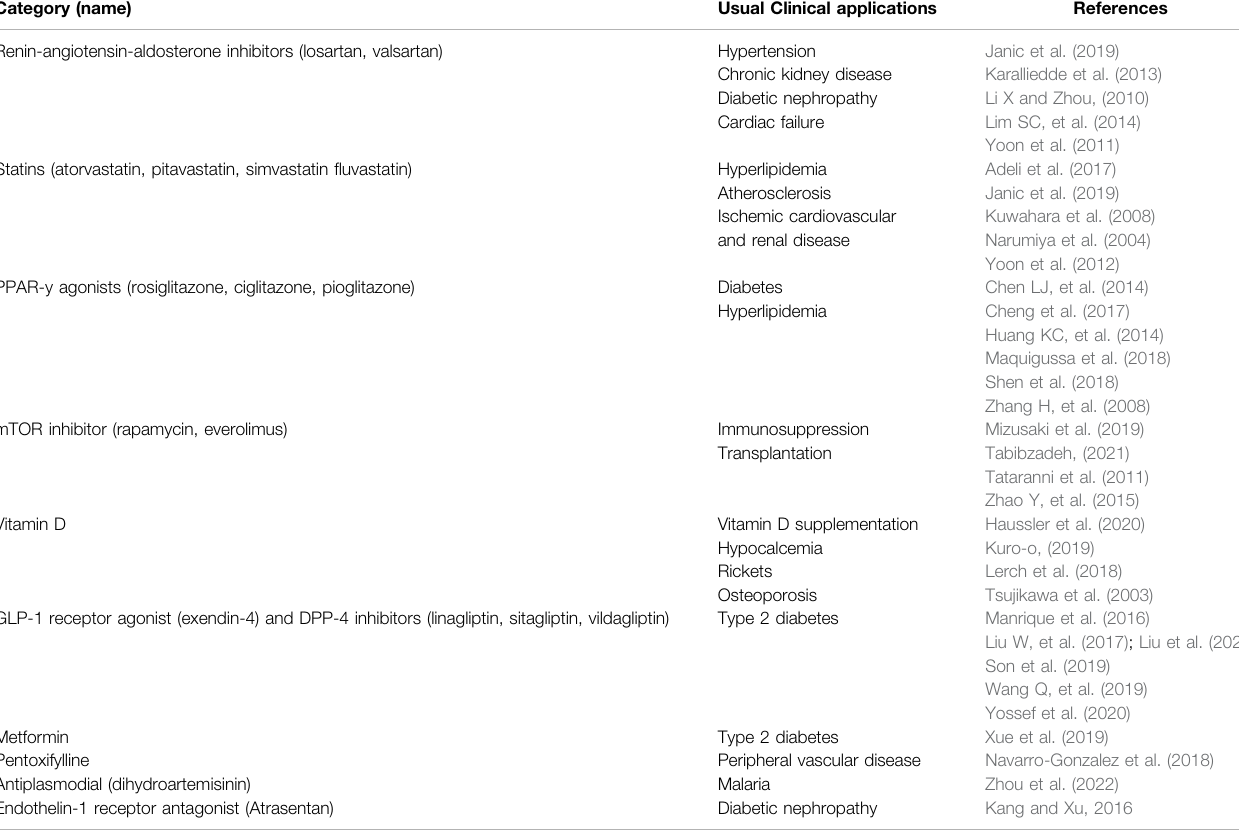
TABLE 2 | Examples of current clinical drugs that increase